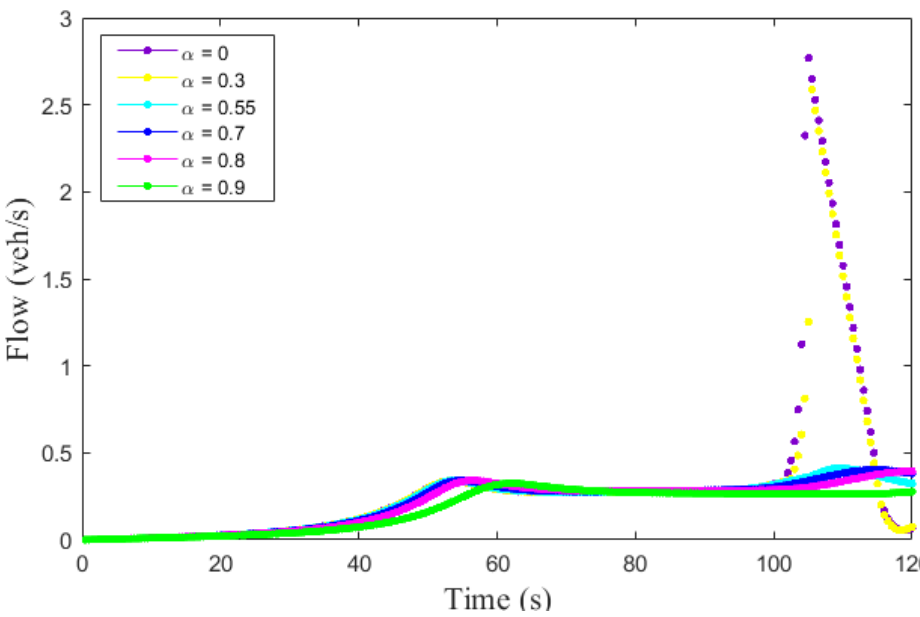
Figure 7. Traffic flow evolution over time with the proposed model over an 800 m circular road. The traffic density behavior of the ID and proposed models is given in Figure 8. This shows that for the ID model with δ = 1, the density between 0 m and 29.97 m at 118 s is 0.014. It then increases to 0.034 at 189.8 m and decreases to 0.015 at 462.8 m, as shown in Figure 8a. The density between 0 s and 35.5 s at − 96.57 m is 0.14, which indicates a traffic queue. After the queue dissipates, the density at 118 s gradually decreases to 0.03 at 189.8 m, as shown in Figure 8a. With δ = 4, the density between 0 m and 3.33 m at 119.5 s is 0.014. It then increases to 0.04 at 109.9 m, decreases to 0.03 at 166.5 m, and decreases further at 512.8 m, as shown in Figure 8b. The density between 0 s and 34.5 s is 0.14, which indicates a traffic queue. The queue then gradually dissipates, and at 118 s, the density decreases to 0.04 at 96.57 m, as shown in Figure 8b. With δ = 20, the density between − 63.27 m and − 36.63 m at 117.5 s is 0.14, which indicates a traffic queue. The density then decreases to 0.01 at 126.5 m, as shown in Figure 8c. The density between 0 s and 35.0 s is 0.14, which indicates a traffic queue. The density at 62.0 s gradually decreases to 0.06 at − 69.9 s. The queue develops again at 74.0 s and − 39.96 m, with a density of 0.14, and at 120 s is between − 63.27 m and − 36.63 m, as shown in Figure 8c. Figure 8a–c show that as δ increases the changes in density over time increase, which indicates that the model is not